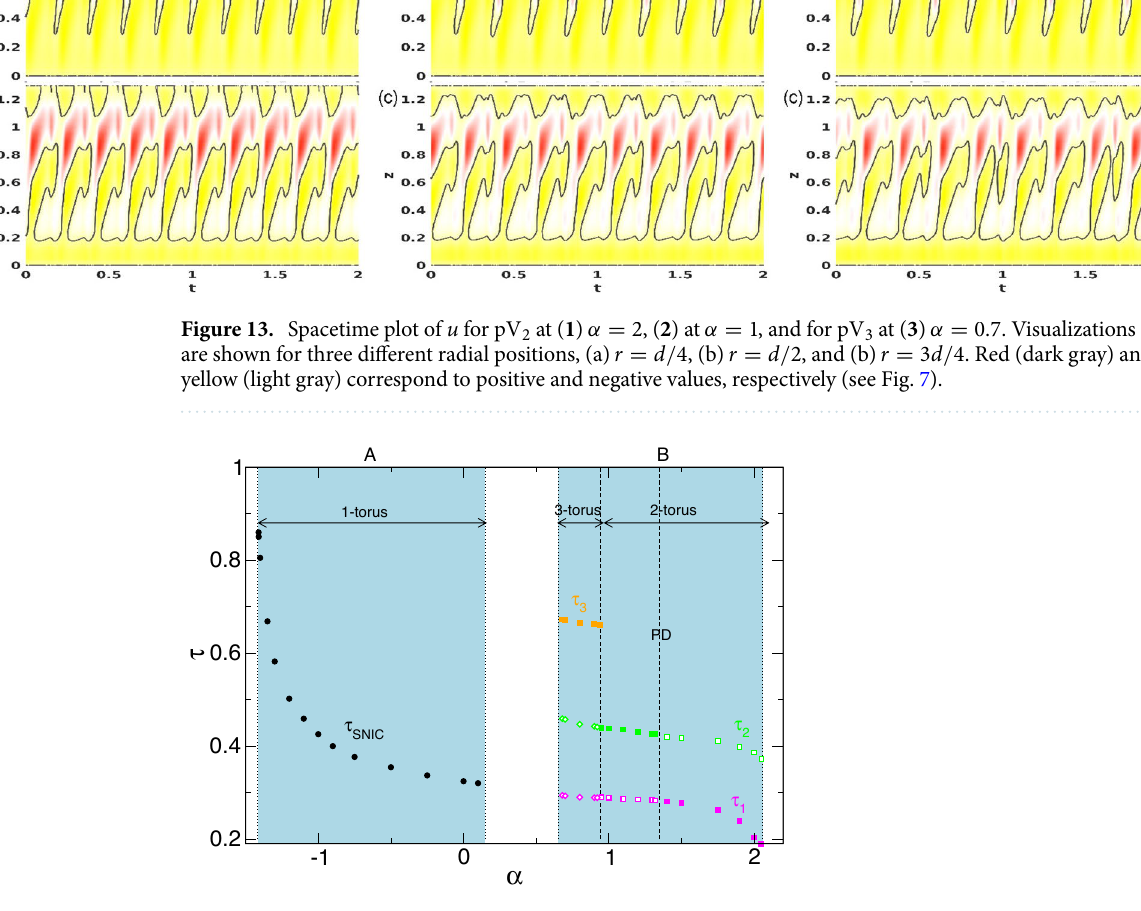
Figure 14. Variation of τ with radial flow α for stable pV states. Note that in region 0.15 < α < 0.67 , pVs do not appear. Filled symbols highlight the basic period (see PSDs in Fig.